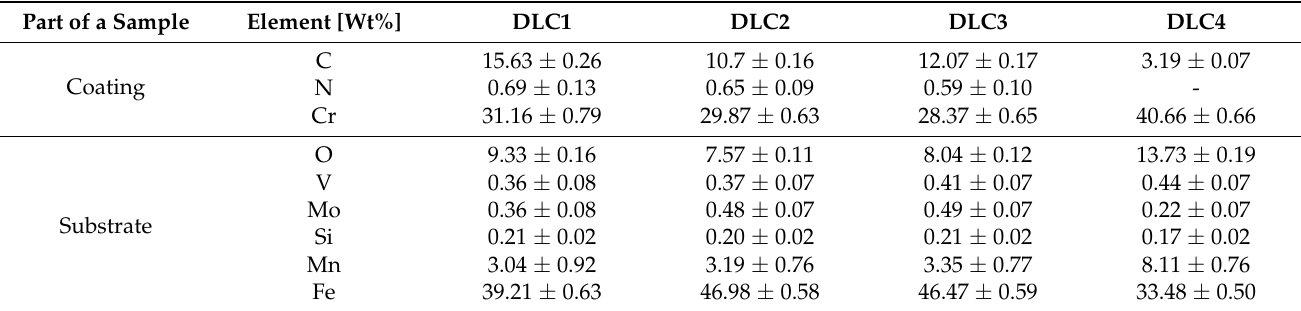
Table 9. Amounts of elements on the surface after laser stripping of the DLC C